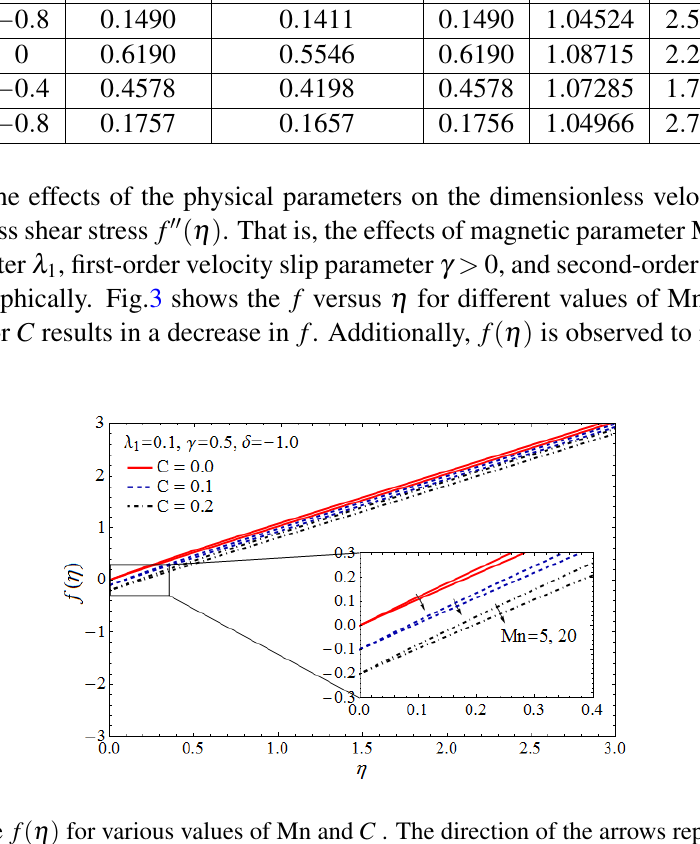
The dimensionless velocity and shear stress profiles for different combinations of parameters are